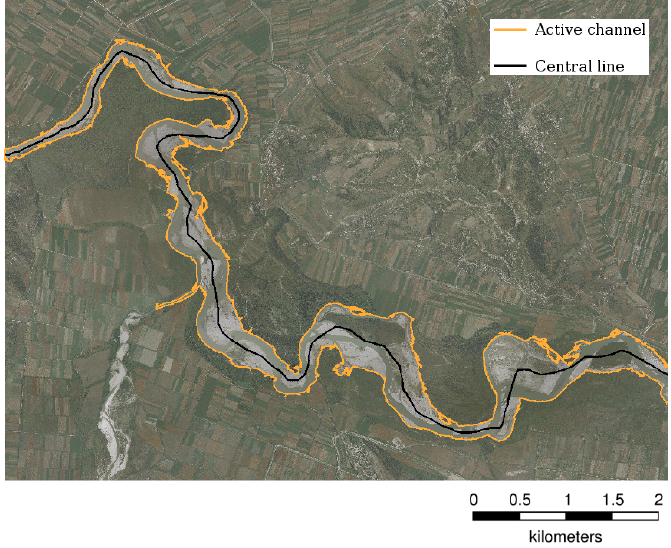
Figure 5. Example of detected active channel and